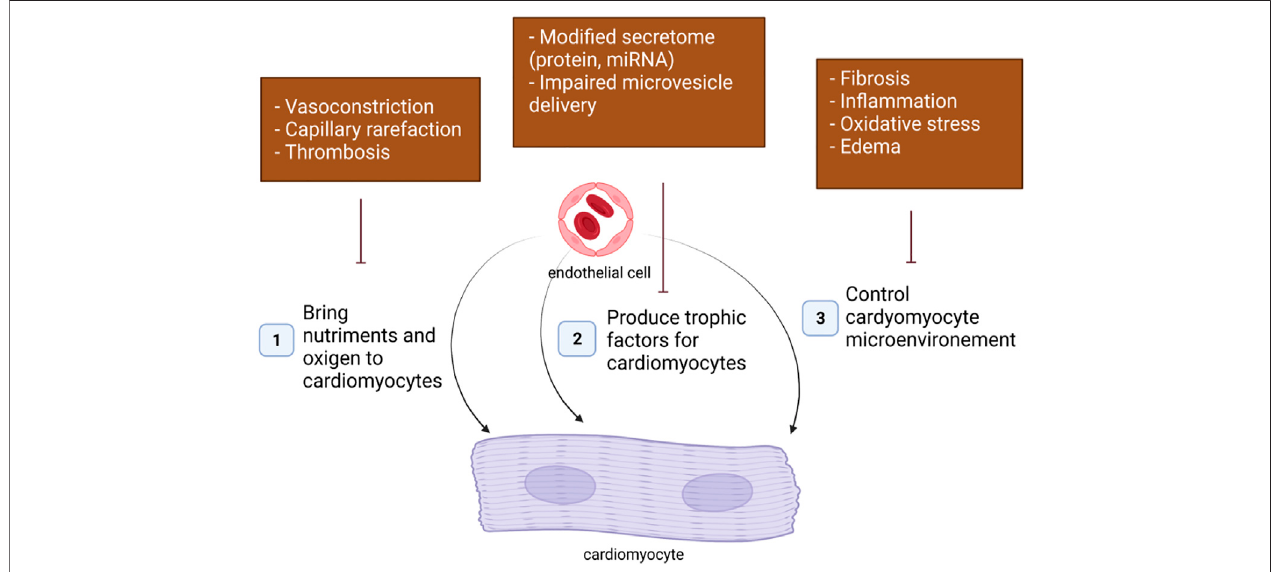
FIGURE 1 | Endothelial cells may affect cardiomyocyte homeostasis in many ways.